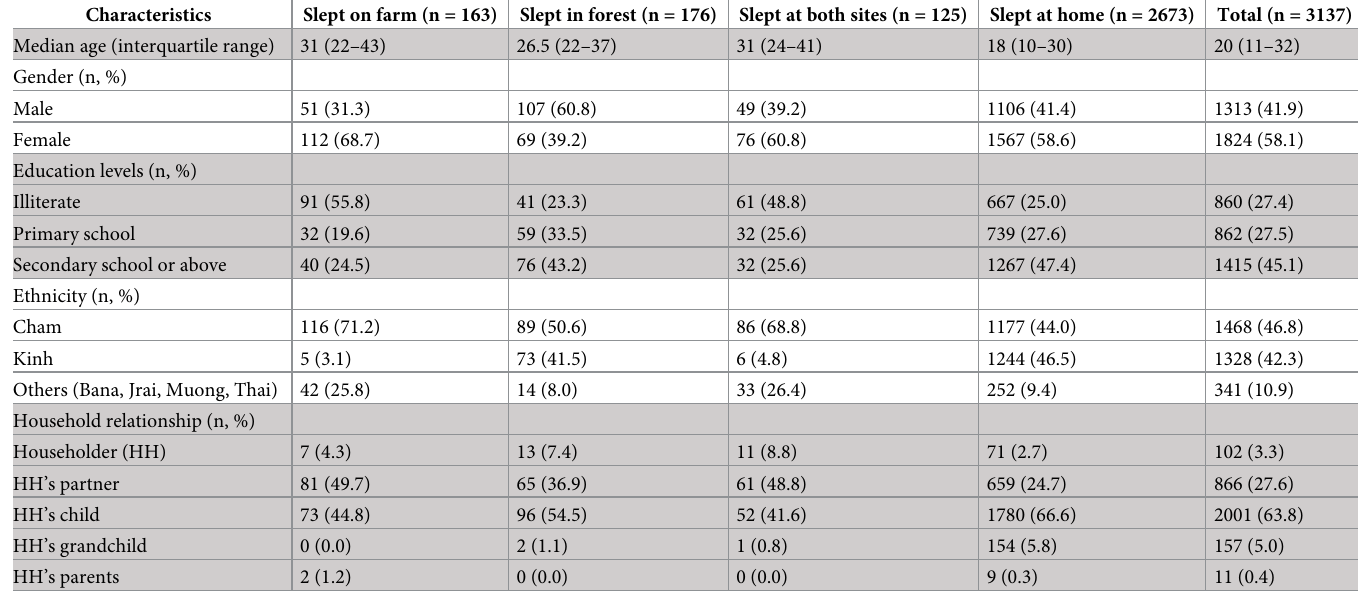
Table 2. Socio-demographic characteristics of respondents’ associated household members by sleeping sites in Dong Xuan District, Phu Yen Province, 2016.